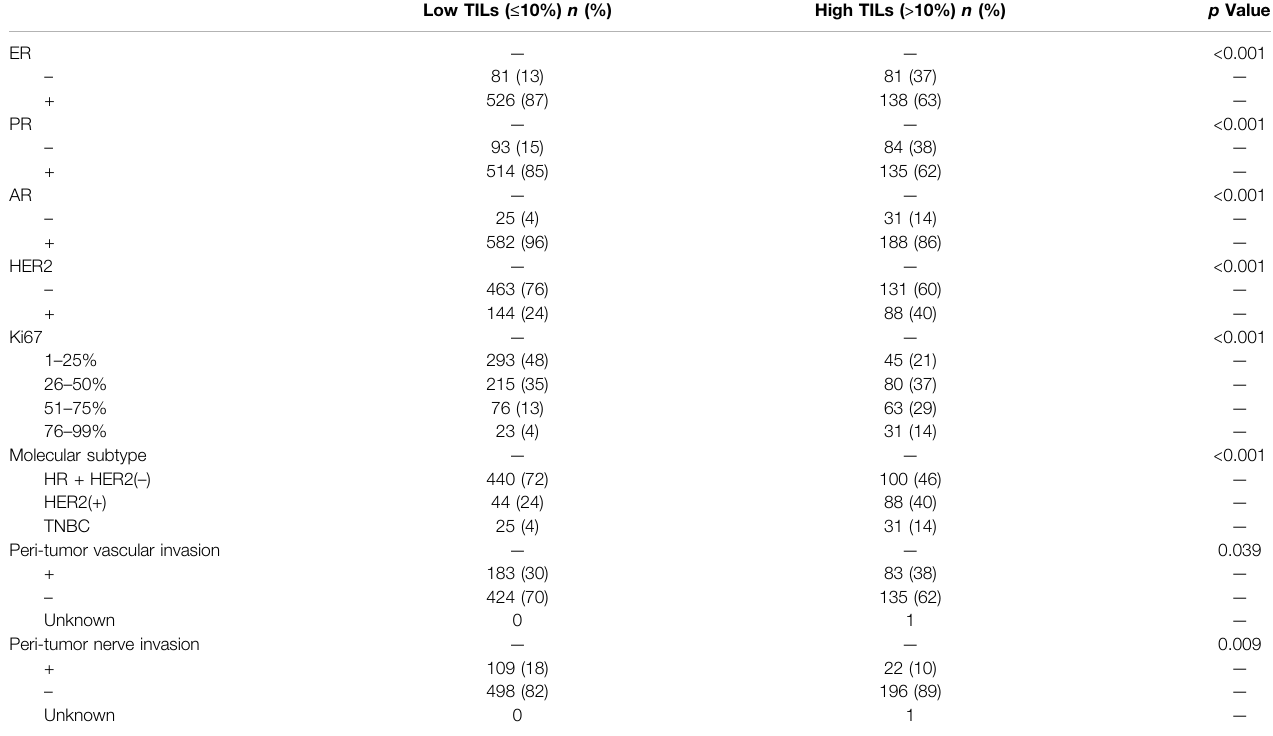
TABLE 2 | correlations between Pathological features and